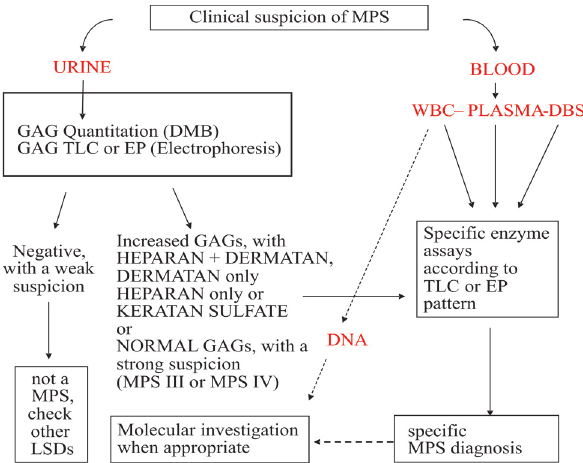
Figure 2 - Proposed flow-chart for the laboratory diagnosis of MPS (dashed line indicates that test is optional for diagnosis). MPS - muco- polyssacaridosis; GAGs - glycosaminoglycans; LSDs - lysosomal storage diseases; DMB - Dimethyleneblue (method used for GAG quantitation); TLC - thin layer chromatography; EP - electrophoresis; WBC - white blood cells; DBS - dried blood